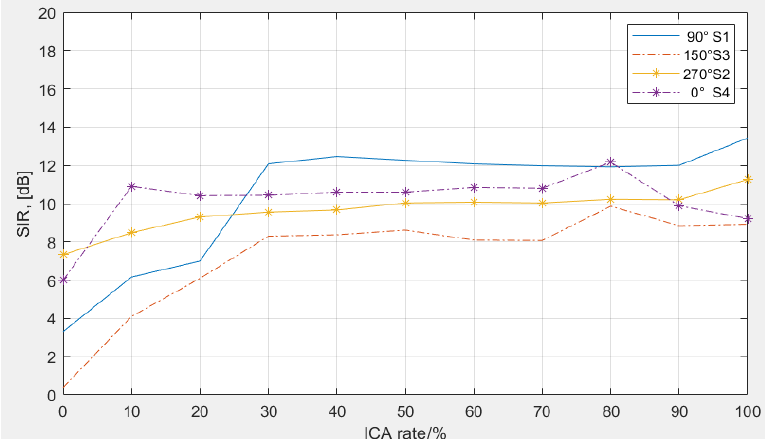
Figure 13. SIR improvement with modified separation under four sources in Room B.